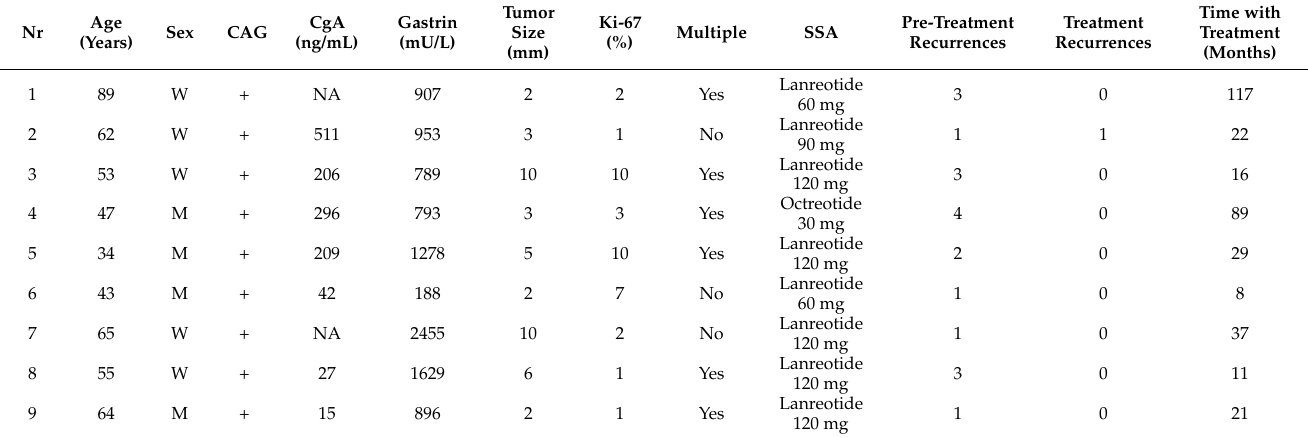
Table 2. Clinical and biochemical characteristics of the study